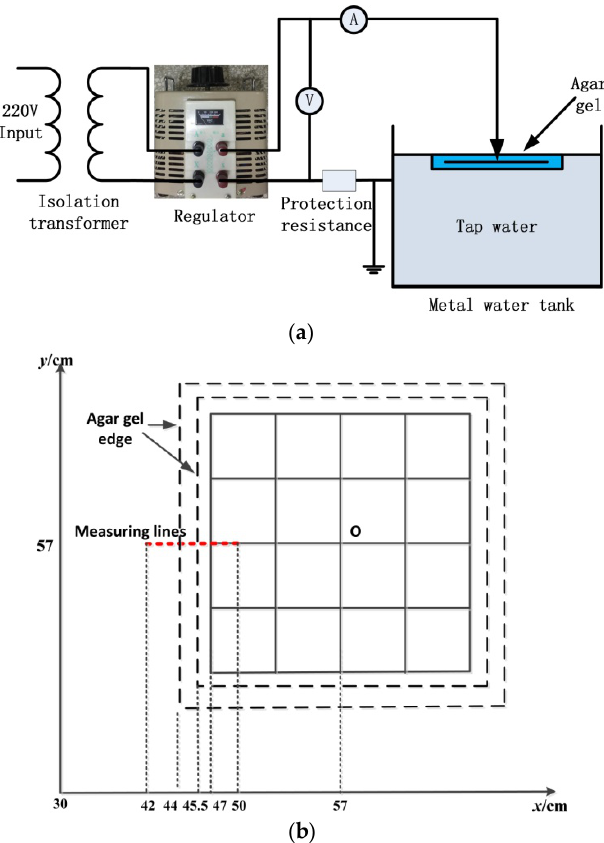
Figure 7. Grounding simulation test. ( a ) Test platform; ( b ) measuring lines with agar and grounding